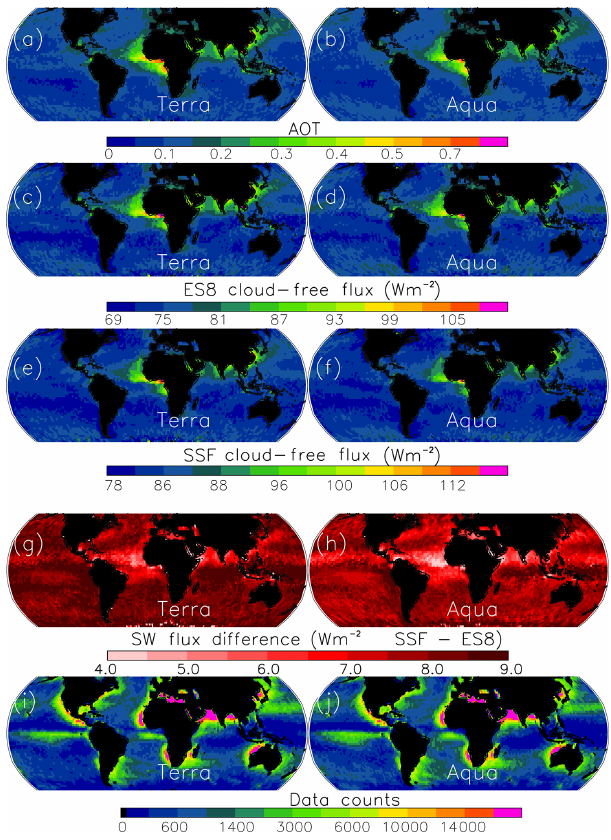
Figure 5. (a) The spatial distribution of seasonally averaged AOTs using Terra MODIS DT AOT data from the collocated Terra MODIS–CERES dataset for the study period of 2000–2015, at a spatial resolution of 2 ◦ × 2 ◦ (latitude / longitude). (b) Similar to (a) , but using the collocated Aqua MODIS–CERES dataset for the study period of 2002–2015. (c) Seasonally averaged CERES ES-8 cloud-free SW flux constructed using the collocated Terra MODIS– CERES dataset for the study period of 2000–2015. (d) Similar to (c) , but using the collocated Aqua MODIS–CERES dataset for the study period of 2002–2015. (e–f) Similar to ( c and d ), but for the seasonally averaged CERES SSF cloud-free SW fluxes. (g) Differ- ence between cloud-free SW flux from (e) and (c) . (h) Similar to (g) , but for Aqua. (i) Collocated Terra MODIS–CERES data counts for every 2 ◦ × 2 ◦ (latitude / longitude) bin. (j) Similar to (i) , but for